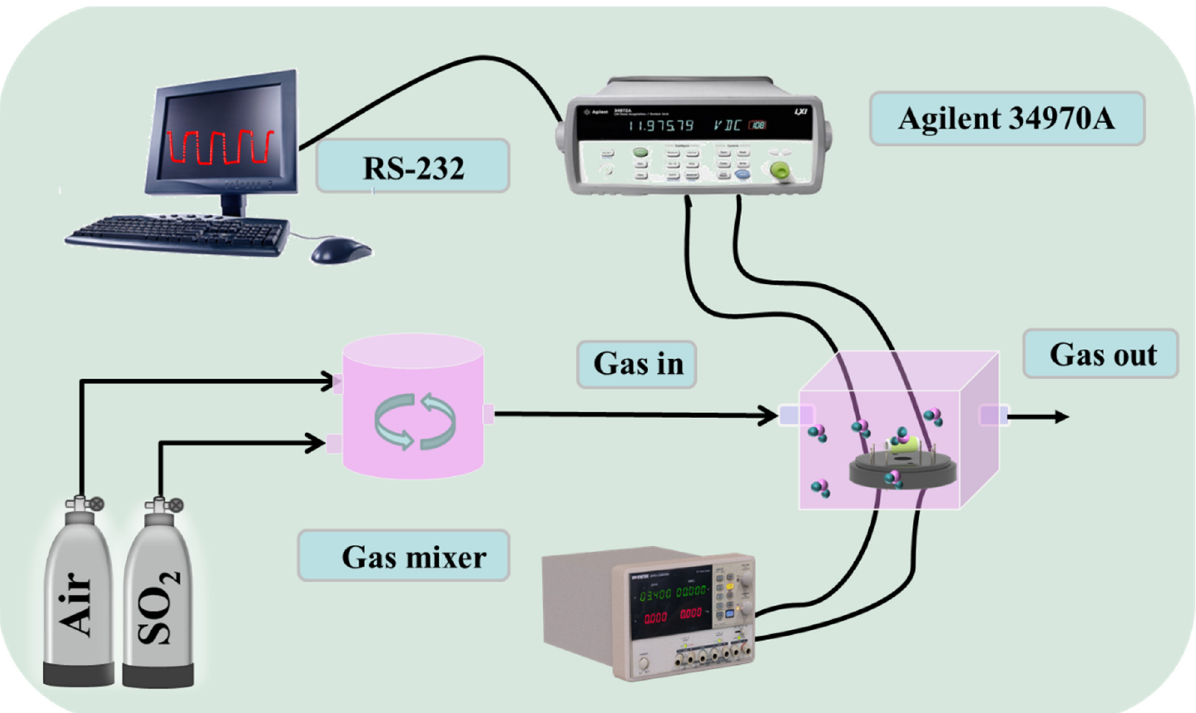
Figure 3. Schematic illustration of sensor performance test platform.